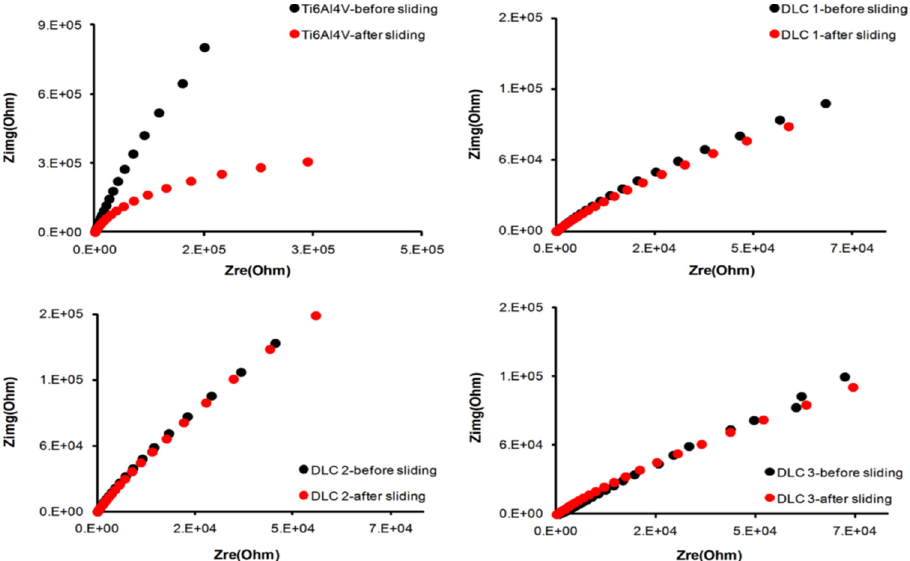
Figure 5. Electrochemical impedance spectra before and after sliding wear test. (Reprinted from Tribology International, 188, R. Bayón, A. Igartua, J. J. González, and U. Ruiz De Gopegui, Influence of the carbon content on the corrosion and tribocorrosion performance of Ti-DLC coatings for biomedical alloys, 115–125, Copyright (2015), with permission from Elsevier.)